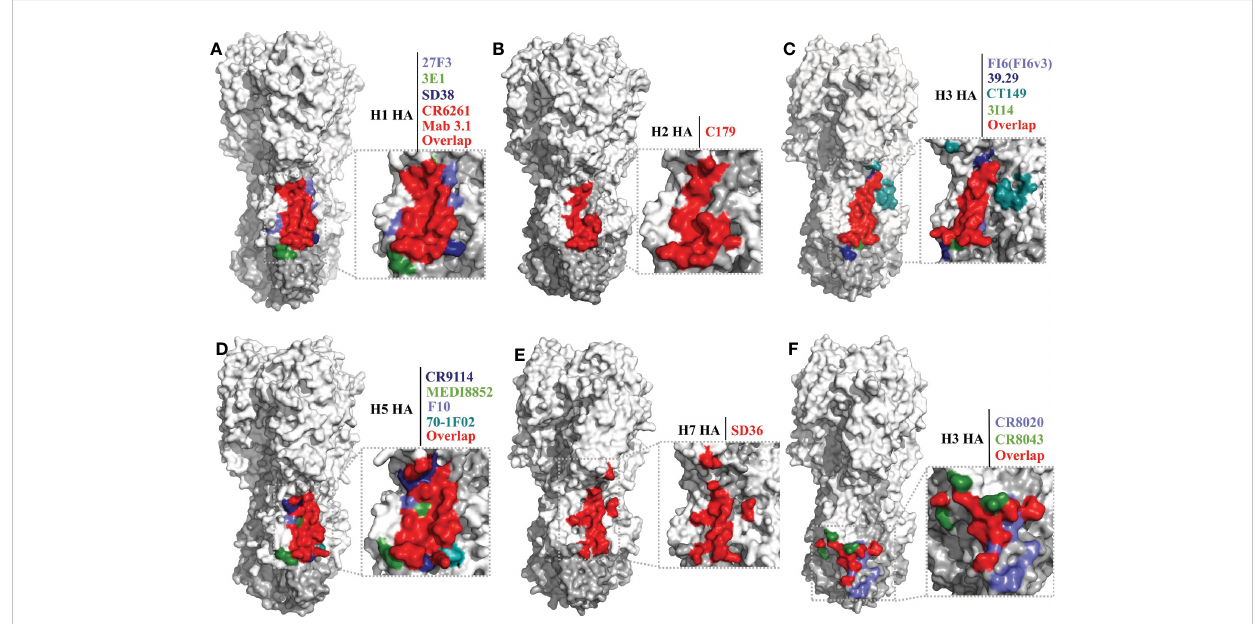
FIGURE 3 Conserved epitopes of the HA stem domain. HA1 is shown in white, HA2 in gray. (A – E) are epitope footprints of bnAbs binding the hydrophobic groove region. (A) H1 HA (PDB ID: 4M4Y) as a model, the epitopes of CR6261 (PDB ID:3GBN) and Mab 3.1 (PDB ID: 4PY8) overlap in red. The non- overlapping residues are shown in light purple (27F3, PDB ID: 5WKO), green (3E1 PDB ID: 5GJT) and dark blue (SD38, PDB ID: 6FYT), respectively. (B) H2 HA (PDB ID: 4HLZ) as a model, the epitope of C179 (PDB ID: 4HLZ). (C) H3 HA (PDB ID: 4FNK) as a model, the non-overlapping residues are shown in light purple (FI6 (FI6v3), PDB ID: 3ZTJ), dark blue (39.29, PDB ID: 4KVN), blue-green (CT149, PDB ID:4UBD), and green (3I14, PDB ID: 6WF0), respectively. (D) H5 HA (PDB ID: 4MHH) as a model, the non-overlapping residues are shown in dark blue (CR9114, PDB ID: 4FQI), green (MEDI8852, PDB ID: 5JW4), light purple (F10, PDB ID: 3FKU), and blue-green (70-1F02, PDB ID: 6B3M), respectively. (E) H7 HA (A/tree sparrow/ Shanghai/01/2013) as a model, the epitope of SD36 (PDB ID: 6FYU). (F) Epitope footprint of bnAbs binding to the fusion peptide region. H3 HA (PDB ID: 4FNK) as a model, the non-overlapping residues are shown in light purple (CR8020, PDB ID: 3SDY) and green (CR8043, PDB ID: